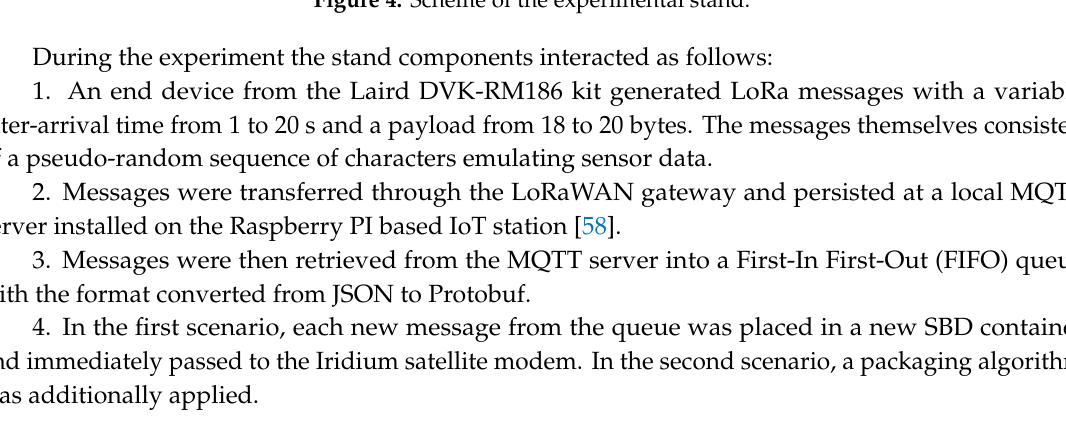
Figure 4. Scheme of the experimental stand.